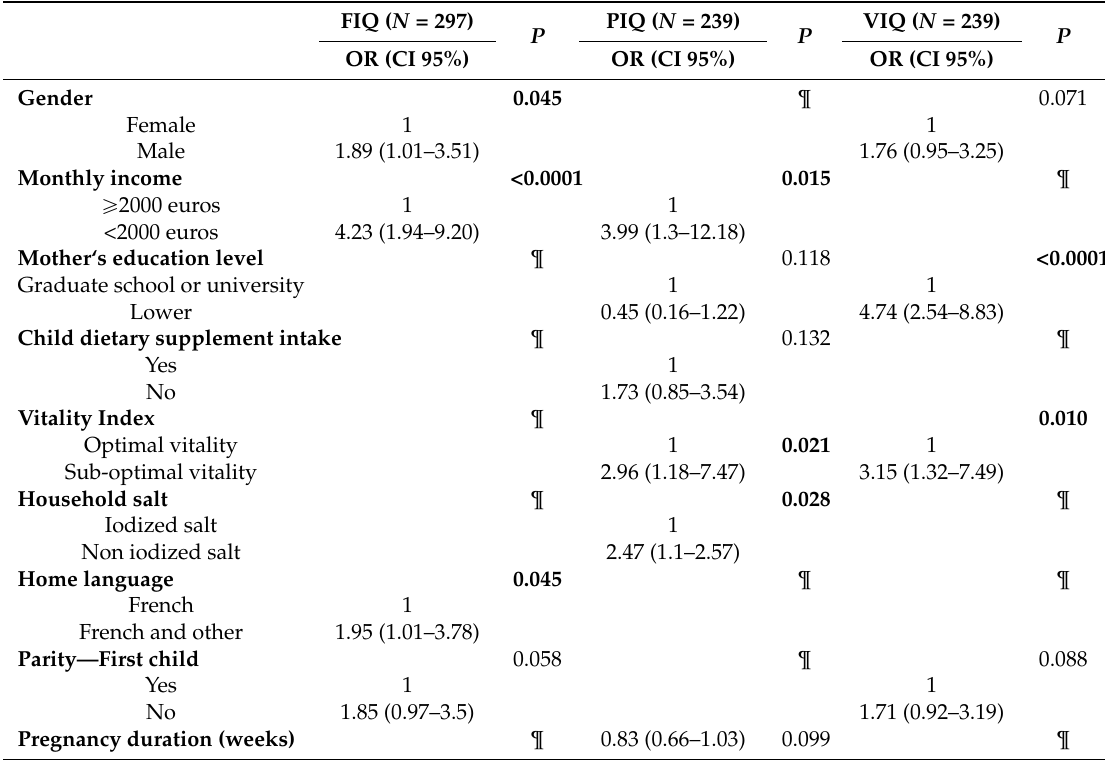
Table 6. Predictors of cognitive scores <85 assessed with multiple logistic regression. PsychoTSH study, Belgium,